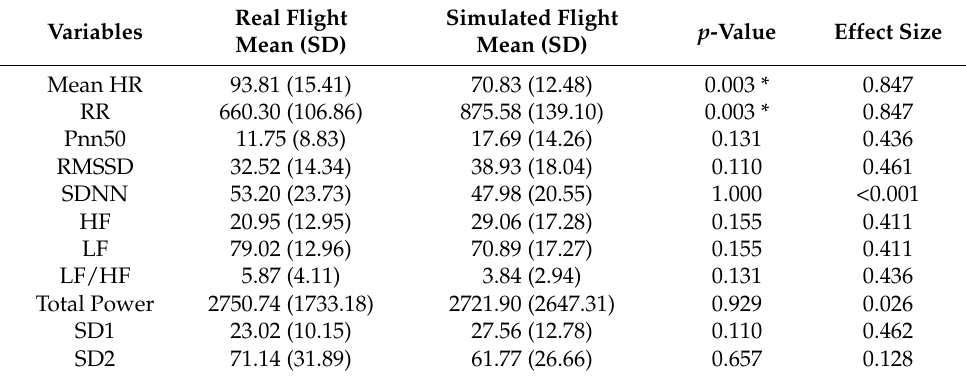
Table 4. HRV during simulated and real